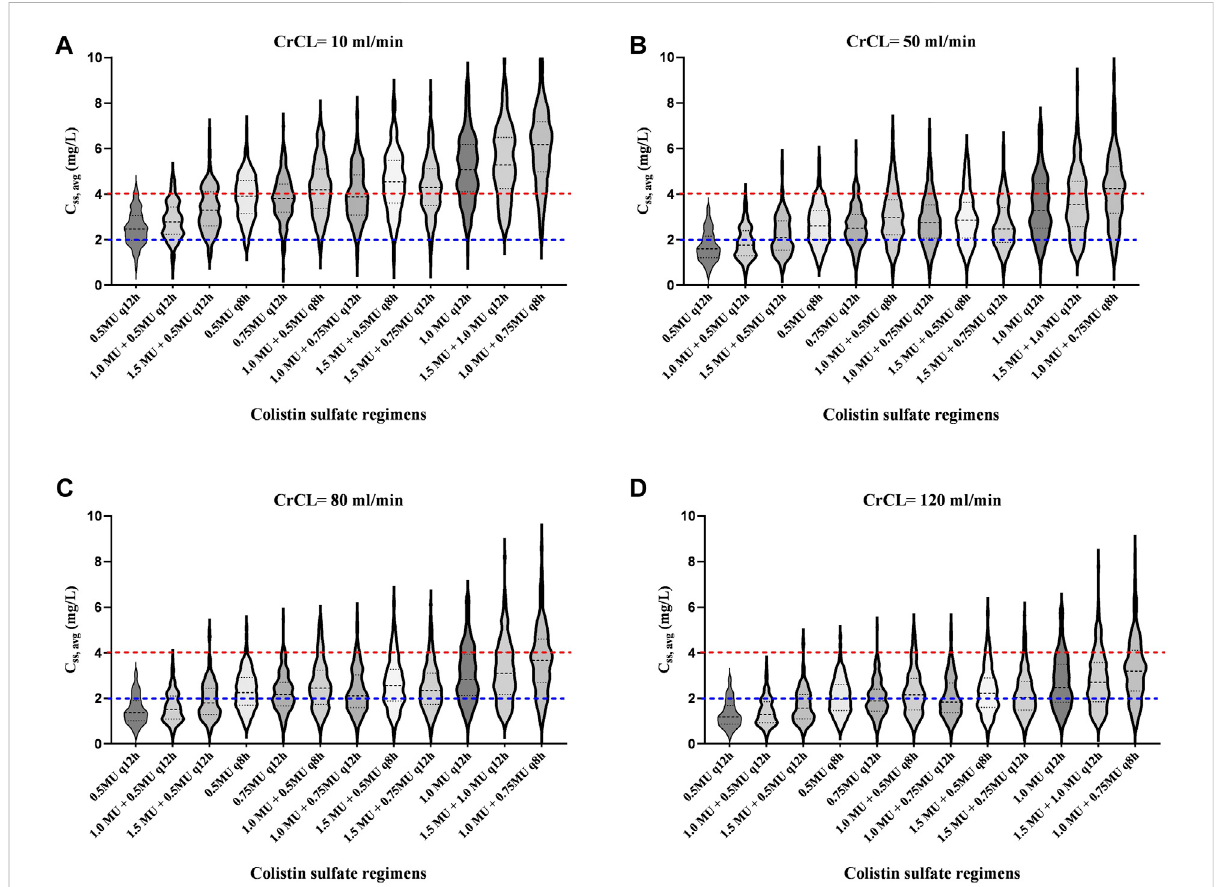
FIGURE 5 Violin plots of simulation results of average steady-state plasma colistin concentration (C ss, avg ) for dosing regimens with various CrCL values. The dotted lines represent the interquartile of simulated exposure; the solid lines represent the median of simulated exposure; the red dashed lines represent potential toxicity concentration (4 mg/L); the blue dashed lines represent the target concentration (2 mg/L). A to D show the CrCL values of 10 ml/min, 50 ml/min, 80 ml/min and 120 ml/min,